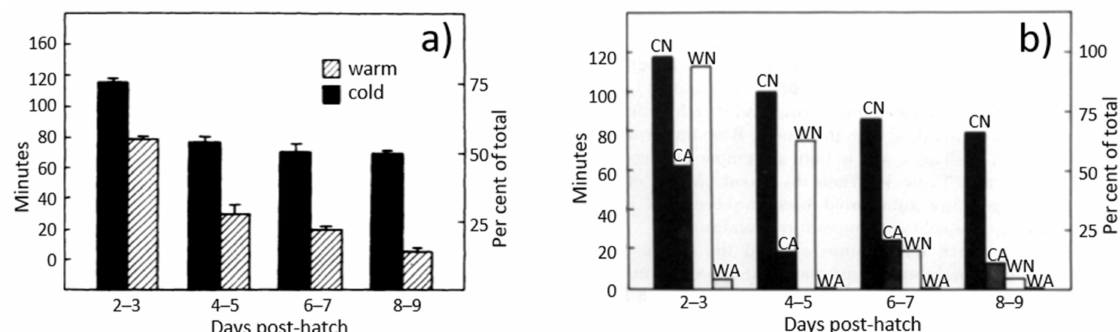
Figure 1. Mean time spent brooding by chicks when in a brood of five under either ( a ) the mother hen 1 (observation period: 180 min) or ( b ) the brooder 2 (observation period: 120 min) [15]. 1 ‘Warm’ is an air temperature of 28 ± 2 ◦ C, and ‘cold’ is 19 ± 1 ◦ C. Error bars equal ± 1 standard error of the mean. 2 ‘N’: brooder was either heated to the hen’s body temperature of 41 ± 0.2 ◦ C or ‘A’: left unheated and, thus, had the same temperature as the air. Air temperature was either ‘W’: 28 ± 2 ◦ C or ‘C’: 19 ± 1 ◦